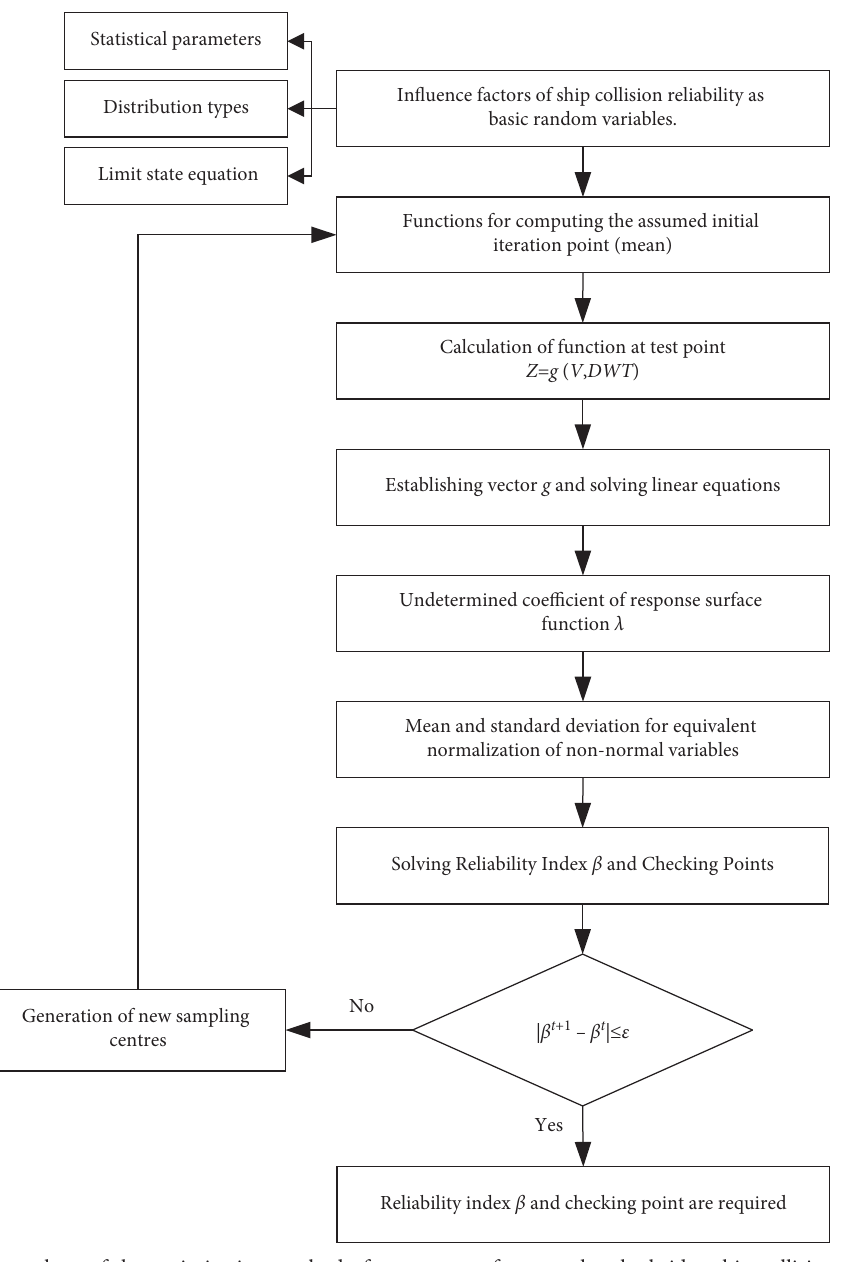
Figure 2: Flow chart of the optimization method of response surface to solve the bridge ship collision